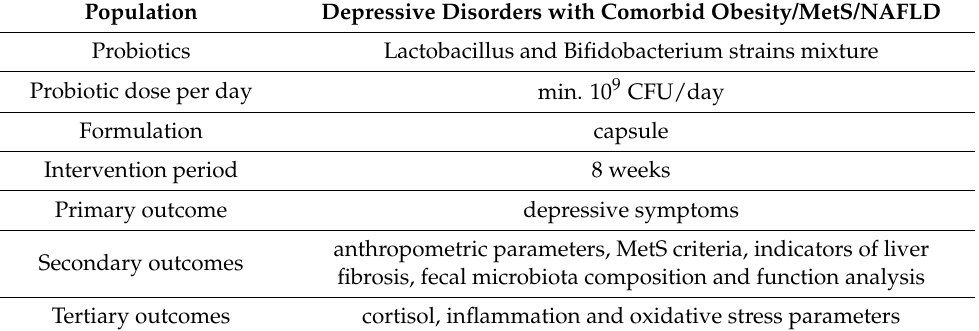
Table 4. Proposed key points of a randomized clinical trial protocol of probiotics efficacy in depressive patients with metabolic abnormalities.